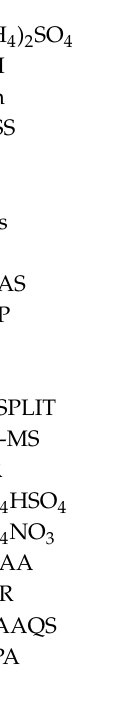
Table S1: Environmental information and contents urban area of Wuhan during winter and summer sampling periods. Table S2: Separate elemental content in each sampling case during winter and summer sampling periods. Table S3: Separate ionic content in each sampling case during winter and summer sampling periods. Table S4: Pearson’s correlation matrix between ions, PMs, meteorological factors and other pollutants. Table S5: Enrichment factors (EFs) of each element in each sampling case. Table S6: Health risk by kinds of element in each sampling case. Author Contributions: Conceptualization, W.W., S.L. and Q.W.; methodology, W.Z., S.D., S.Y.; software,